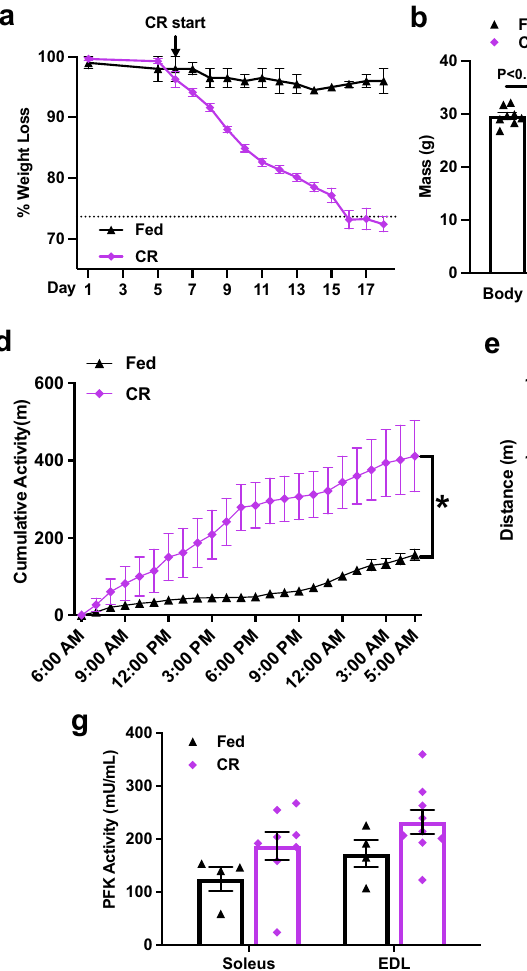
and CR ( n =4) mice performing a maximal endurance performance test (running on a treadmill until exhaustion). g Phosphofructokinase (PFK) activity in the soleus of Fed ( n =4) and CR mice ( n =8) and in the EDL( n =4) of Fed and CR mice( n =9). h Citrate Synthase (CS) activity in the soleus of Fed ( n =8) and